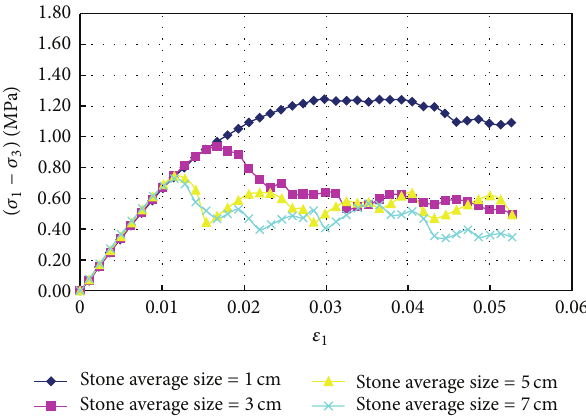
Figure 15: The biaxial compression curves with different average sizes of stone blocks.